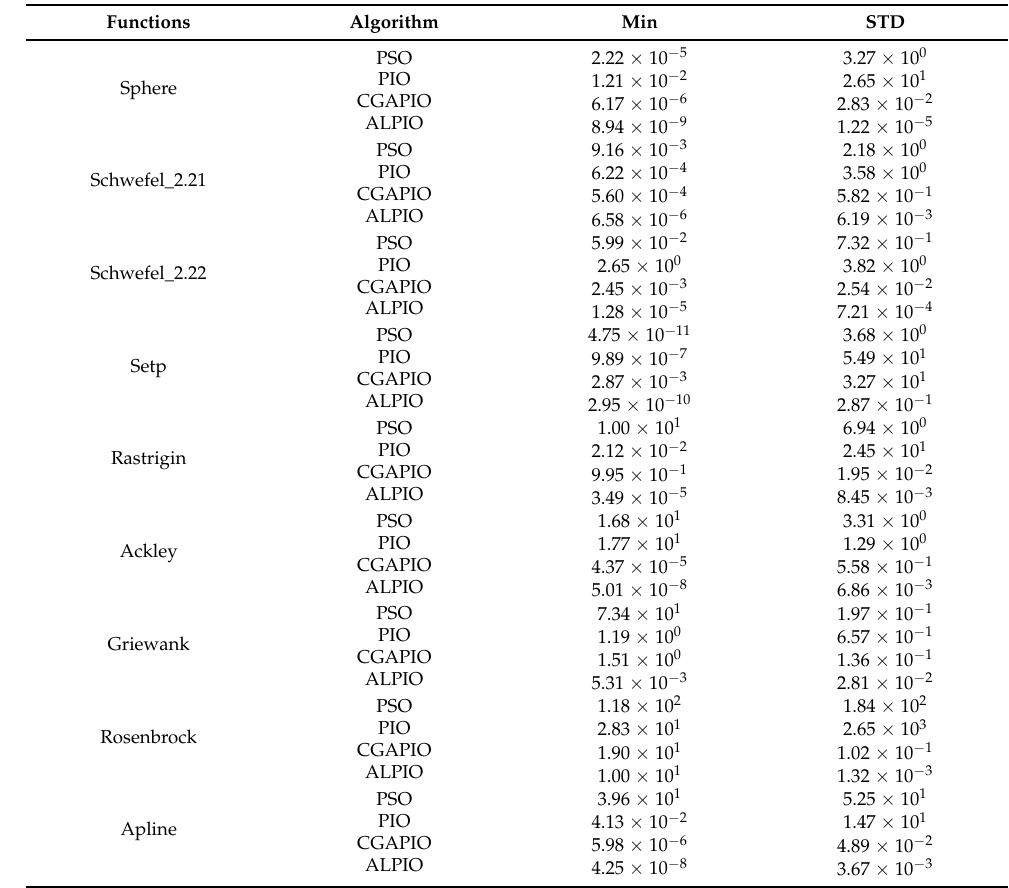
Figure 10. ( a ) Sphere, ( b ) Schwefel_2.21, ( c ) Schwefel_2.22, ( d ) Setp, ( e ) Rastrigin, ( f ) Ackley, ( g ) Griewank, ( h ) Rosenbrock, ( i ) Apline. Table 3. Results of the function